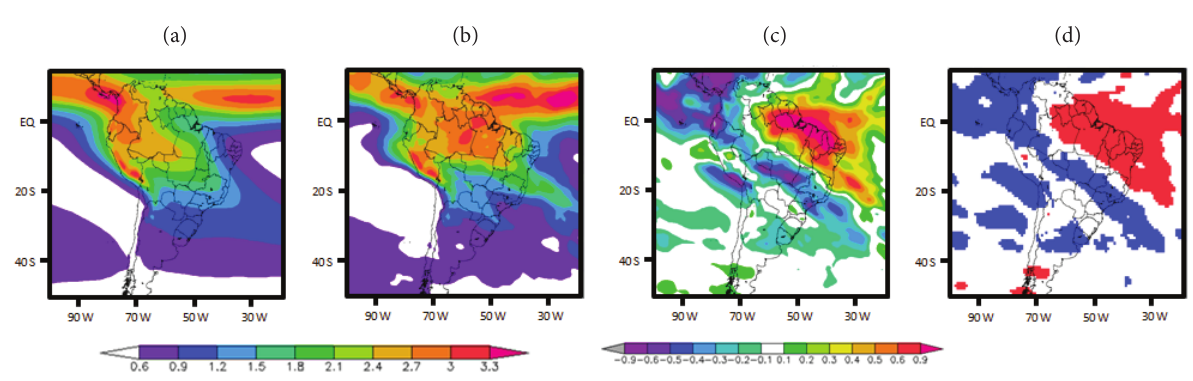
Figure 7. Mean specific humidity at 500 hPa (g/kg) (a) for the dry quarter (SON) in the period 1979-2017, (b) for the 15 days with heavy precipitation and deep convection, and (c) the difference between them, i.e., “b” minus “a”. Data from the ERA-Interim reanalysis were used. (d) Differences are statistically significant at the 95% confidence level (Student’s t-test) over the shaded areas (blue: negative difference; red: